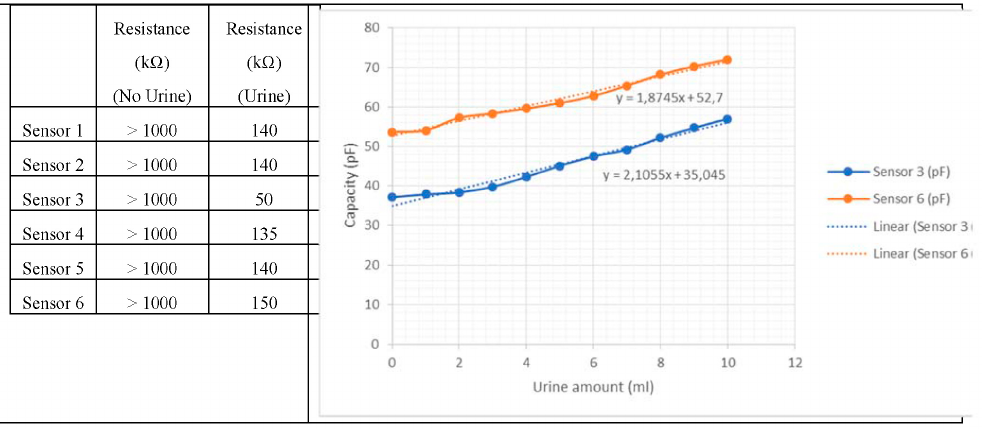
Figure 5. Sensor signals as function of urine. Synthetic urine was used. Left —resistance signal, and right —capacitive